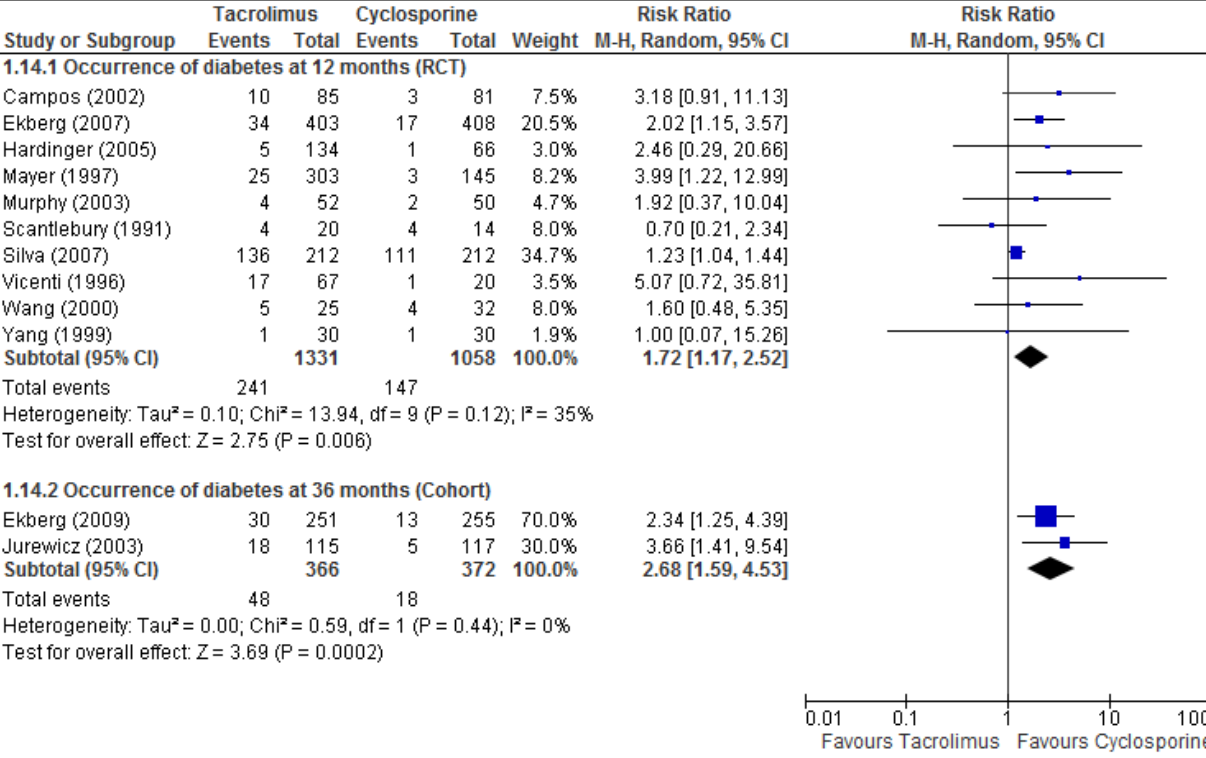
Figure 3. Meta-analysis of diabetes for TAC vs. CsA comparison at 12 and 36